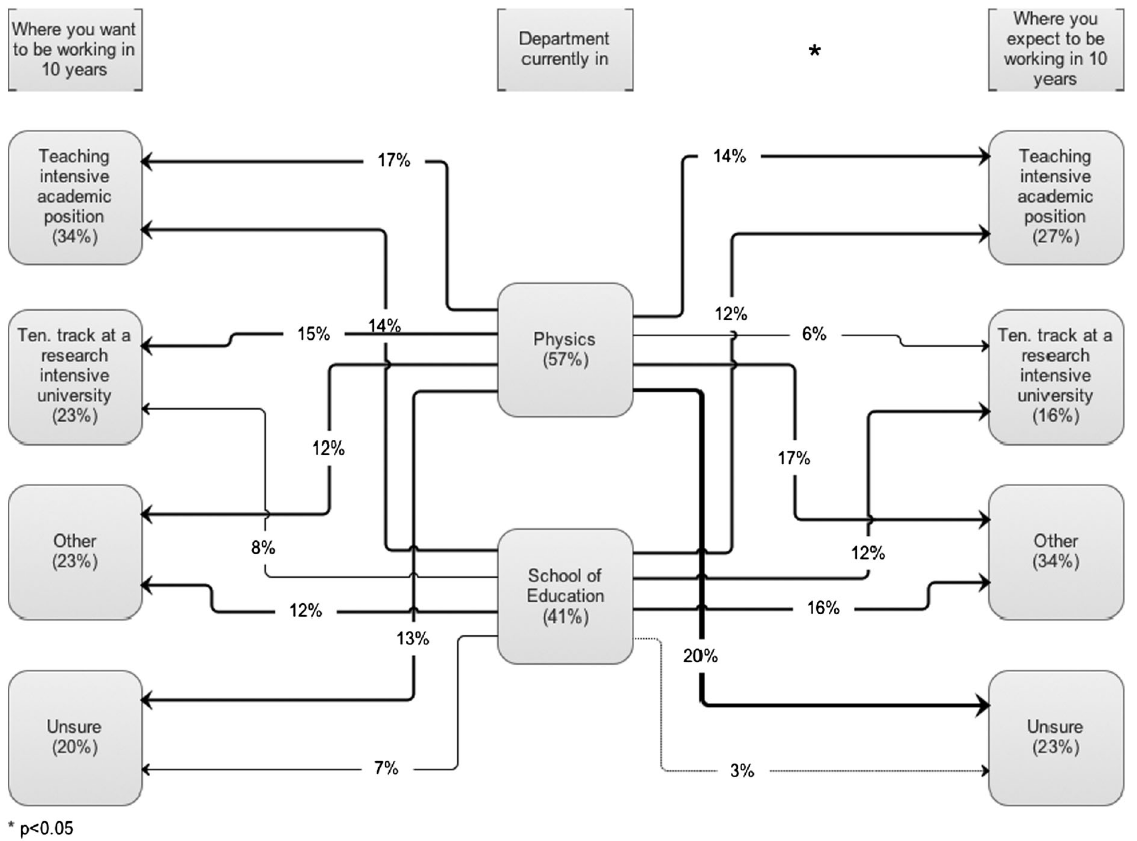
4. Where PER graduate students want to work and expect they will be working in ten years (values are the percentage of the total